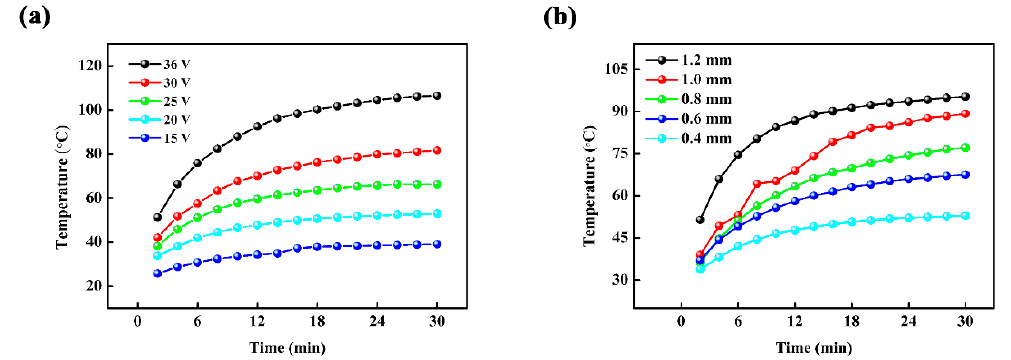
Figure 2. The effects of ( a ) applied voltage and ( b ) carbon-based suspension thickness on the surface temperature of the laminated